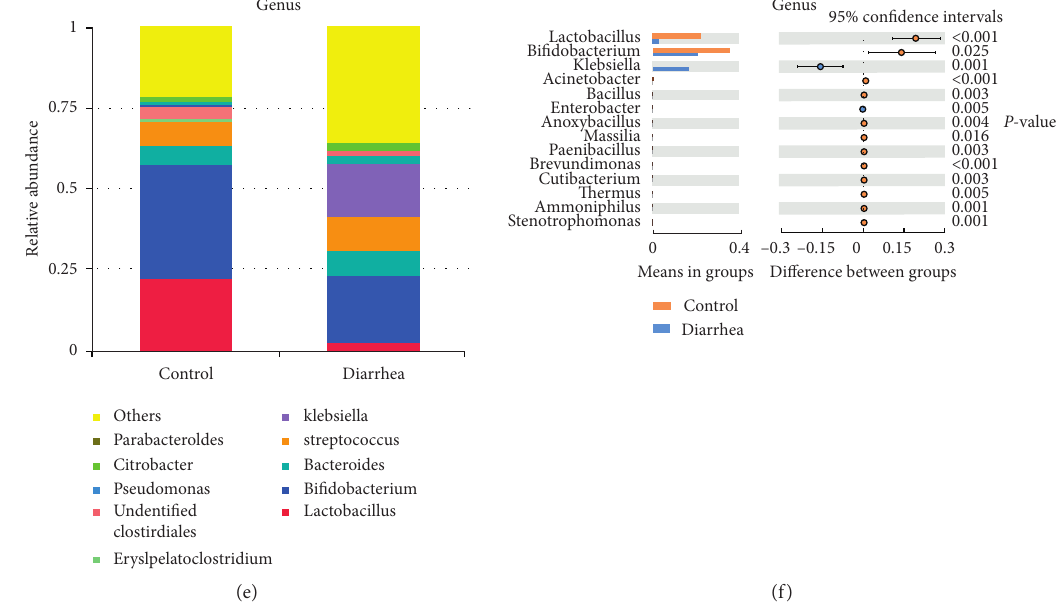
Figure 4: The shift in the gut microbiota of healthy infants and diarrheic infants. The relative abundance of the top 10 microbiota at the phylum (a), order (c), and genus level (e). The genera in the gut microbiota of healthy infants were strikingly different from those in diarrheic infants at the phylum (b), order (d), and genus level